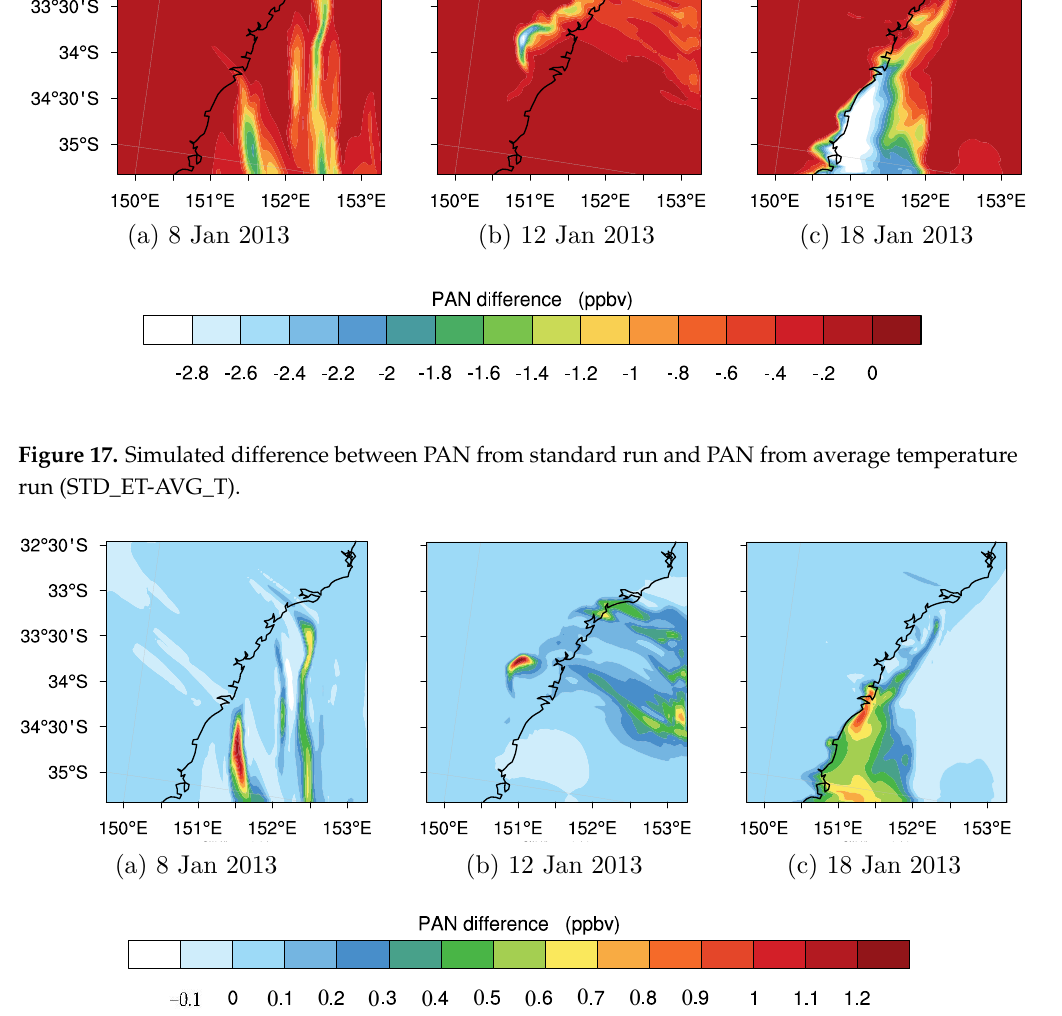
Figure 18. Simulated difference between PAN from standard run and PAN from average emissions run